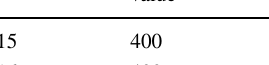
Node number Contaminant